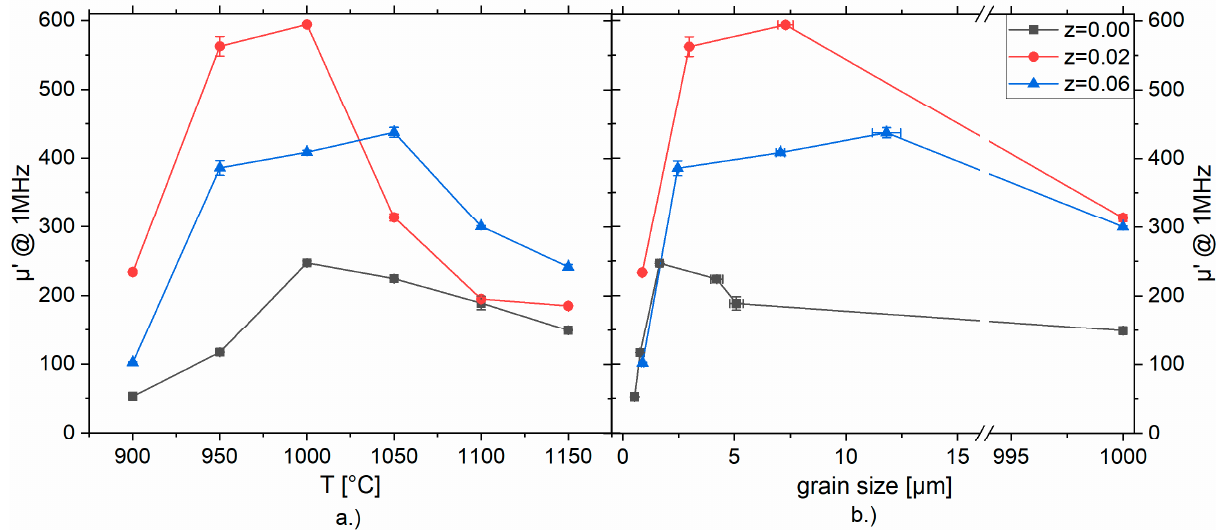
Figure 9. Permeability @ 1MHz ( a ) vs. sintering temperature and ( b ) vs. grain size of ferrites with 0 ≤ z ≤ 0.06 .